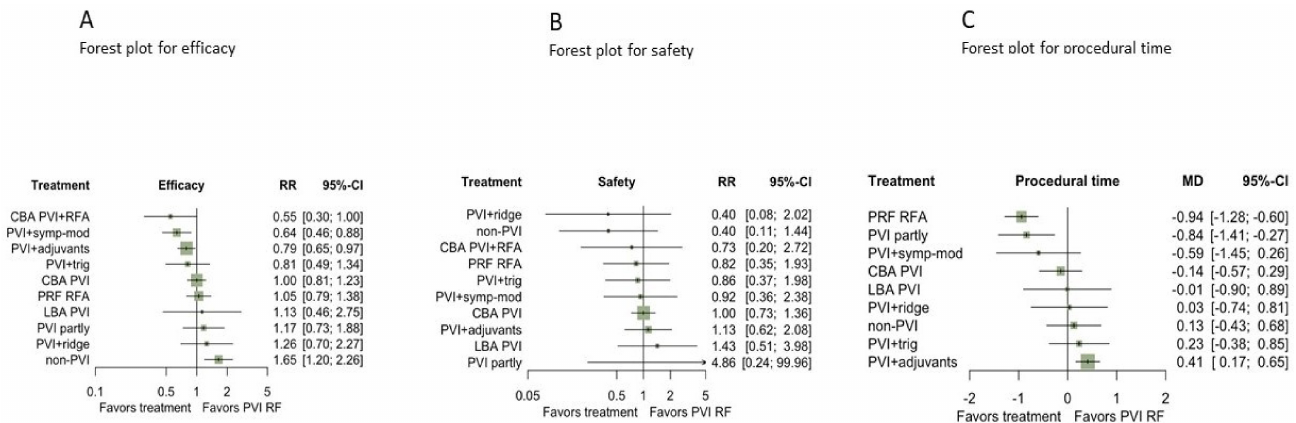
Figure 3. Forest plots for efficacy ( A ), safety ( B ), and procedural time (unit: minutes) ( C ) com- pared with PVI RF reporting the network meta-analysis RRs with their 95% CIs. Abbreviations: CBA: Cryoballoon ablation, HBA: Hot-balloon ablation, LBA: Laser-balloon ablation, PVI: Pul- monary vein isolation, RFA: radiofrequency ablation, trig: trigger ablation, PRF: Phase duty-cycled radiofrequency